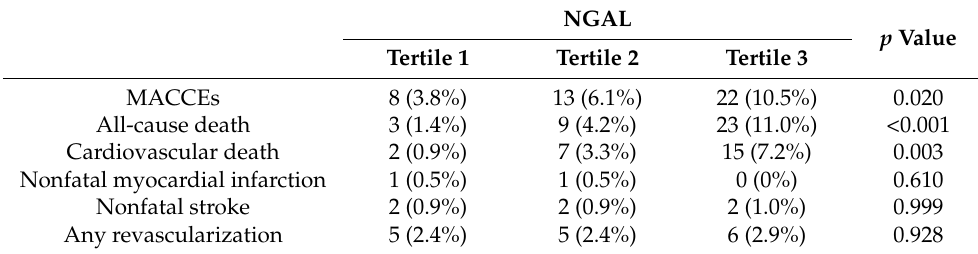
Table 3. Clinical outcomes according to NGAL tertiles.